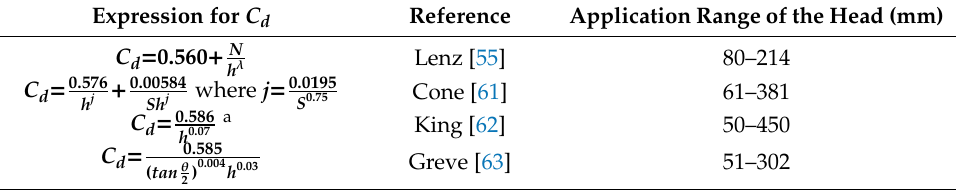
Table 2. Coe ffi cient of discharge expressions for 30 ◦ triangular weirs and their head applicability range. Expression for C